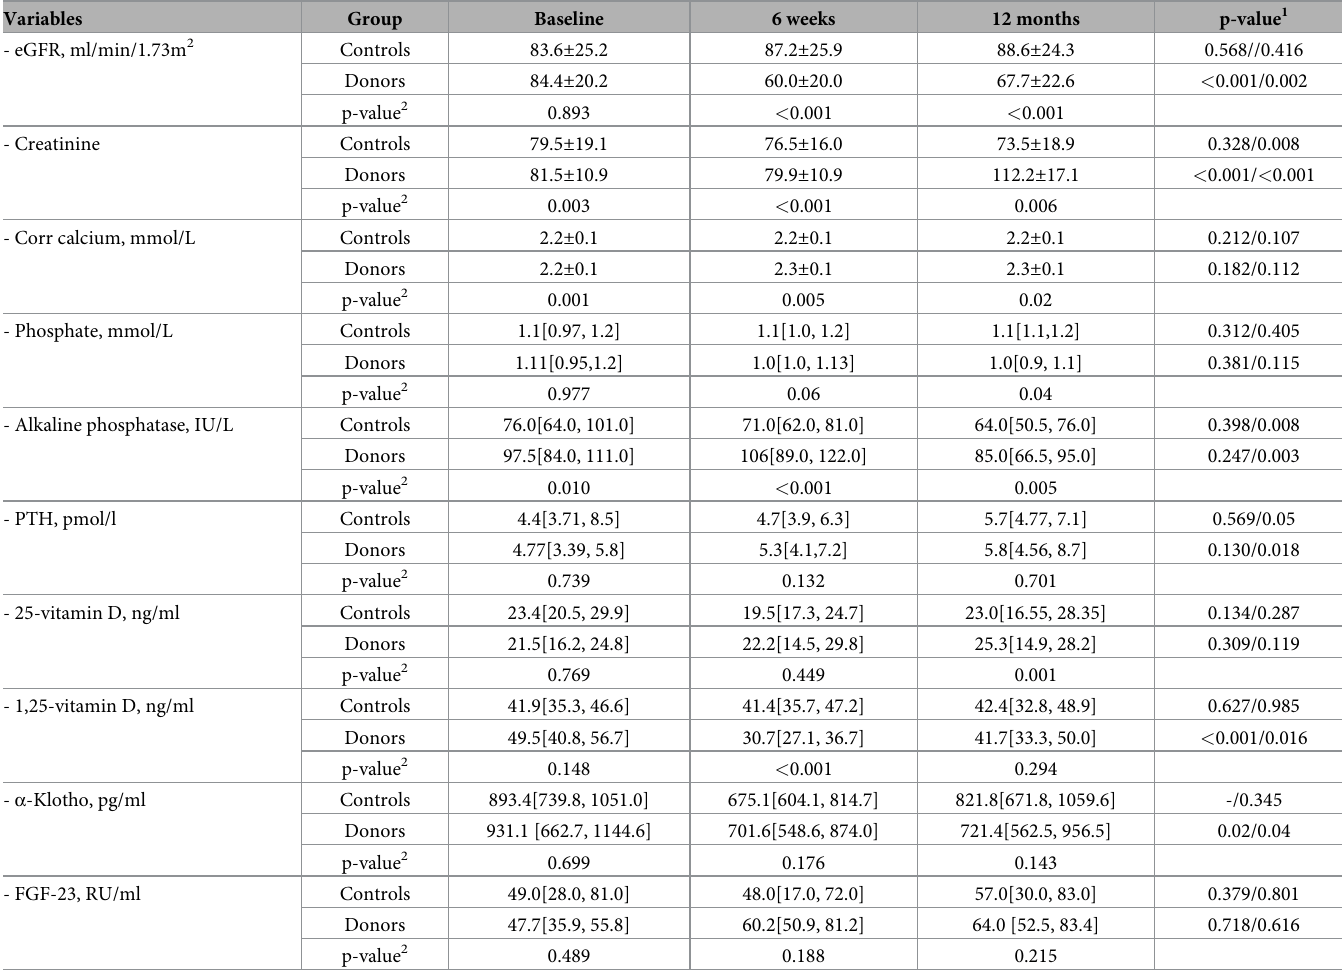
Table 3. Laboratory measurements mid-term after kidney